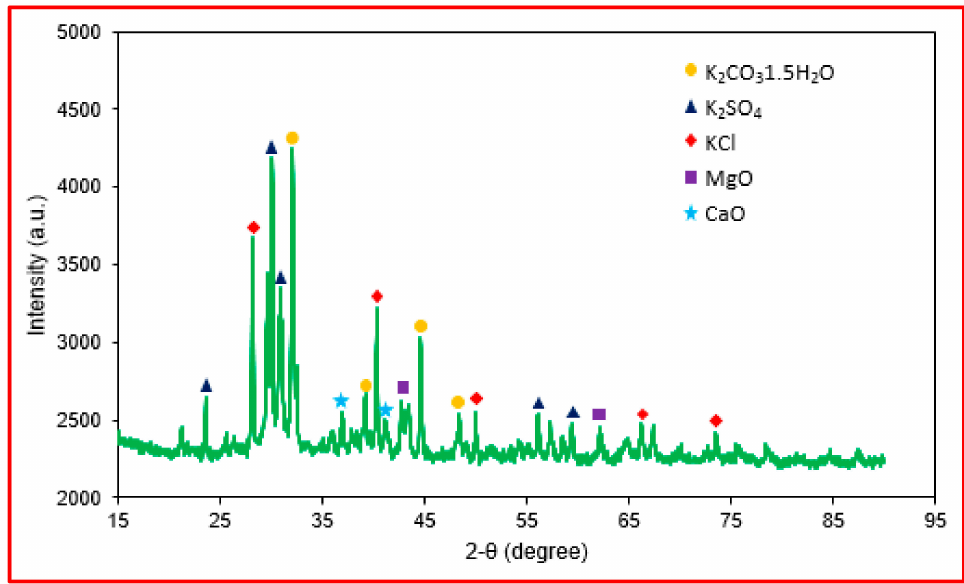
Figure 4. X-ray di ff raction (XRD) pattern of CPP at 600 ◦